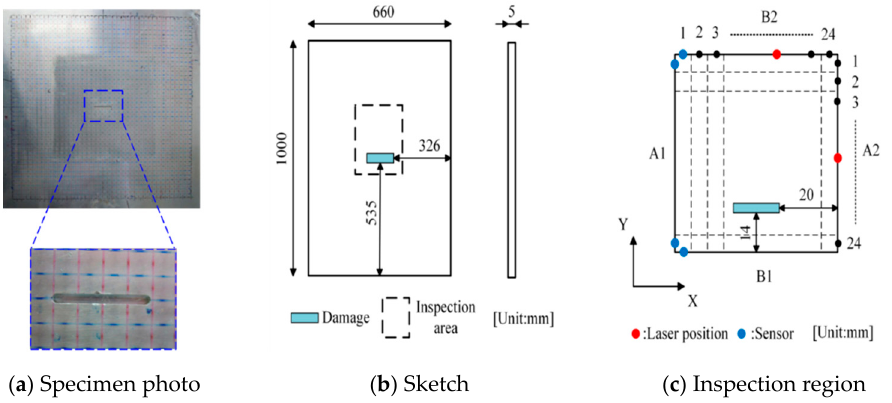
Sensors 2019 , 19 , 2180 Figure 6. Schematic view of the aluminum plate. Figure 6. Schematic view of the aluminum plate.